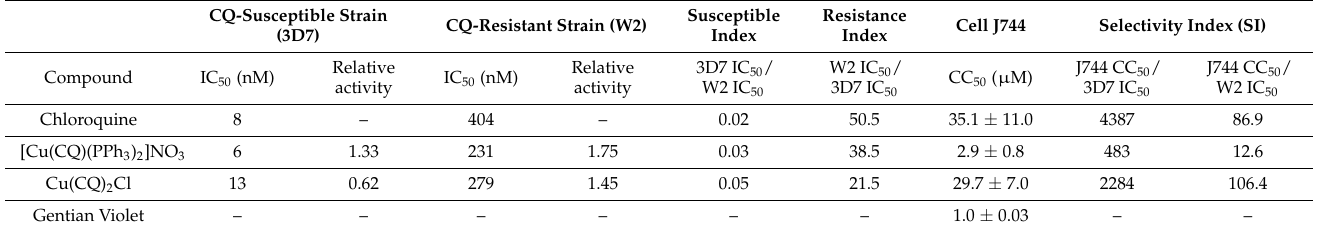
and W2 strains), mammalian cell cytotoxicity and activity indexes.